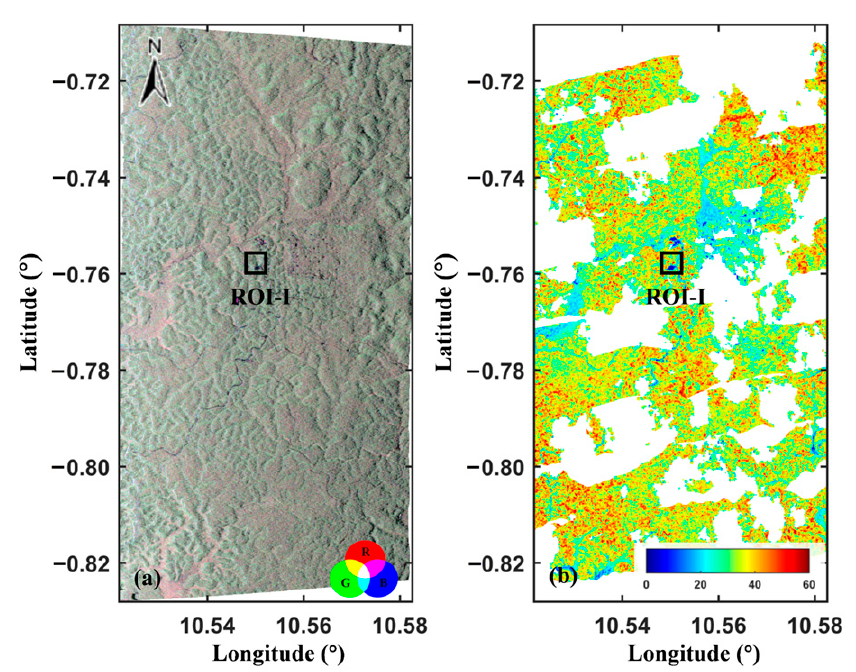
Figure 2. Mabounie study area: ( a ) average of master and slave PauliRGB images; ( b ) LiDAR CHM. Note that in the quad-polarization, the red color is S HH − VV , blue color is the S HH + VV , and the green color is 2 S HV .